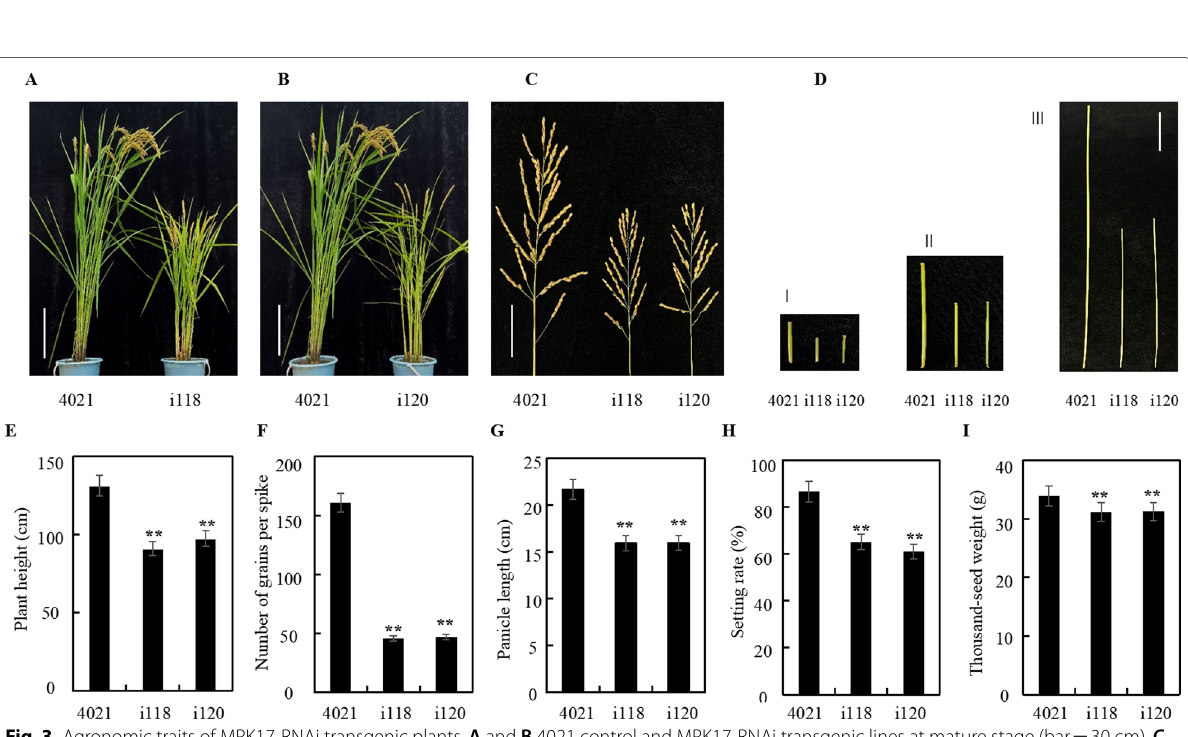
Fig. 3 Agronomic traits of MPK17-RNAi transgenic plants. A and B 4021 control and MPK17-RNAi transgenic lines at mature stage (bar 30 cm). C = Panicles of 4021 and MPK17-RNAi transgenic lines at mature stage (Bar 5 cm). D Internodes of 4021 and MPK17-RNAi transgenic lines at mature = stage (Bar 10 cm). I: the third internode from the top; II: the second internode from the top; III: the upmost internode. E Columns showing plant = height. F Columns showing number of grains per spike. G Columns showing for panicle length. H Columns showing seed setting rate. I Columns showing 1000-grain weight. i118 and i120: independent MPK17-RNAi transgenic lines; 4021: TP309 transgenic line harboring the Xa21 gene. Mean was calculated for eight individual plants. Error bars are standard deviation (SD). “**” designate difference at p < 0.05